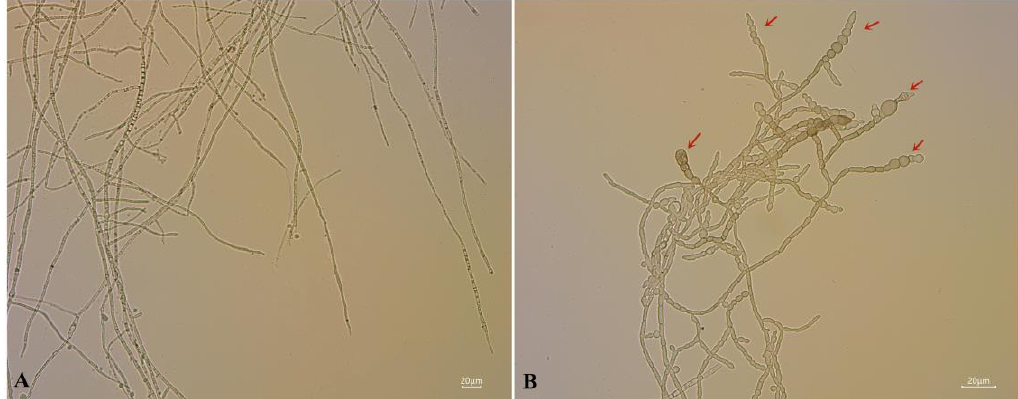
Figure 7. Aseptic filtrate effects on A. alternata mycelial morphology. ( A ) Untreated cells after 12 h. ( B ) Cells treated with 200 mL L −1 aseptic filtrate after 12 h. Note: The position indicated by the red arrows indicates the mycelial spherical protrusions.